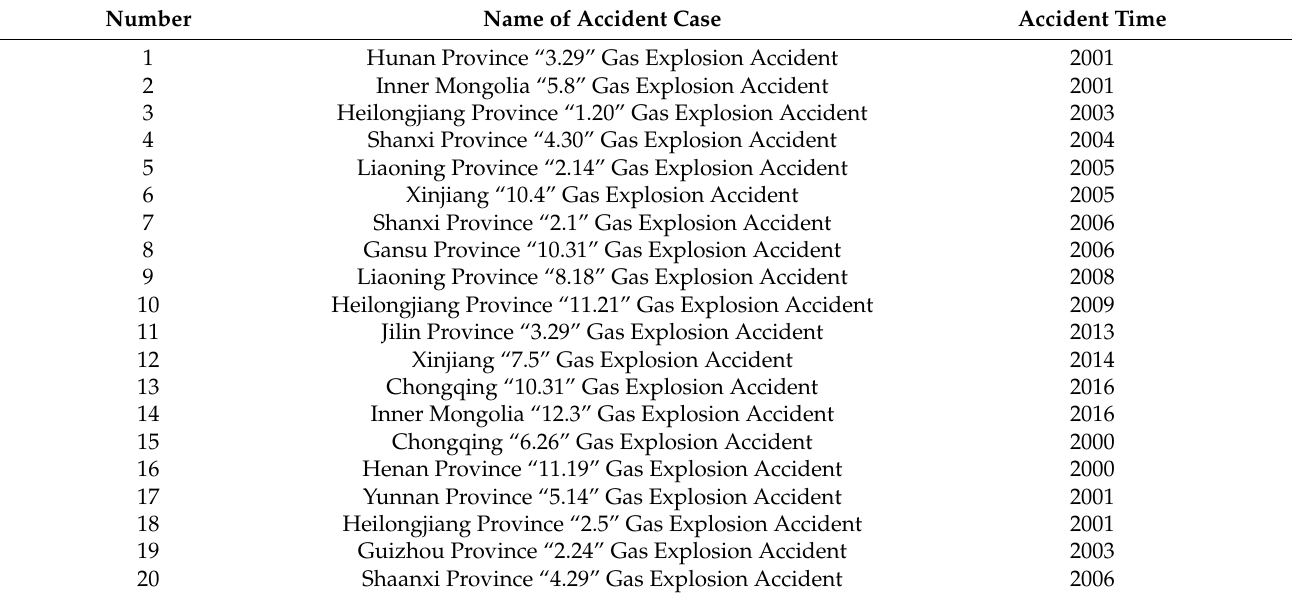
Table 2. Accident case